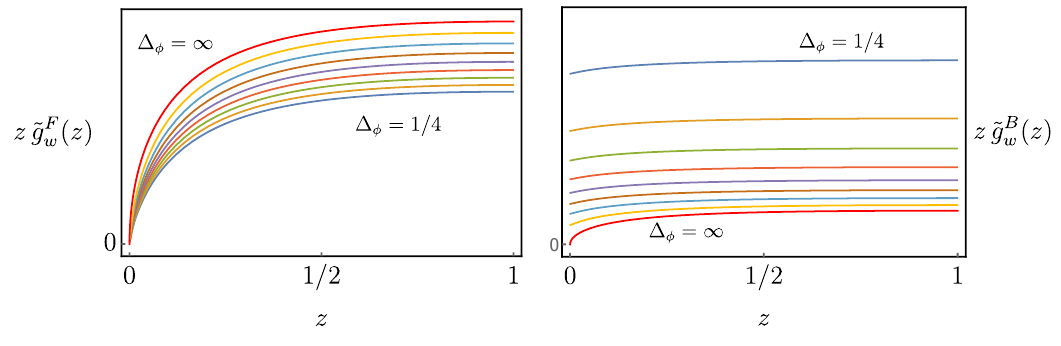
Figure 2 . Functional kernels for values of ∆ φ ranging from ∆ φ ∼ 0 . 25 to ∞ , evaluated for w = 1 / 3 . For clarity we plot the kernels in terms of ˜ g B,F ( z ) ≡ (1 − z ) − 2∆ φ ˆ g B,F ( z ) . For special values of ∆ φ the w w numerical curves above match with analytic expresions. The kernels are positive for all z ∈ (0 , 1) . The rough shape of the curves does not change with w